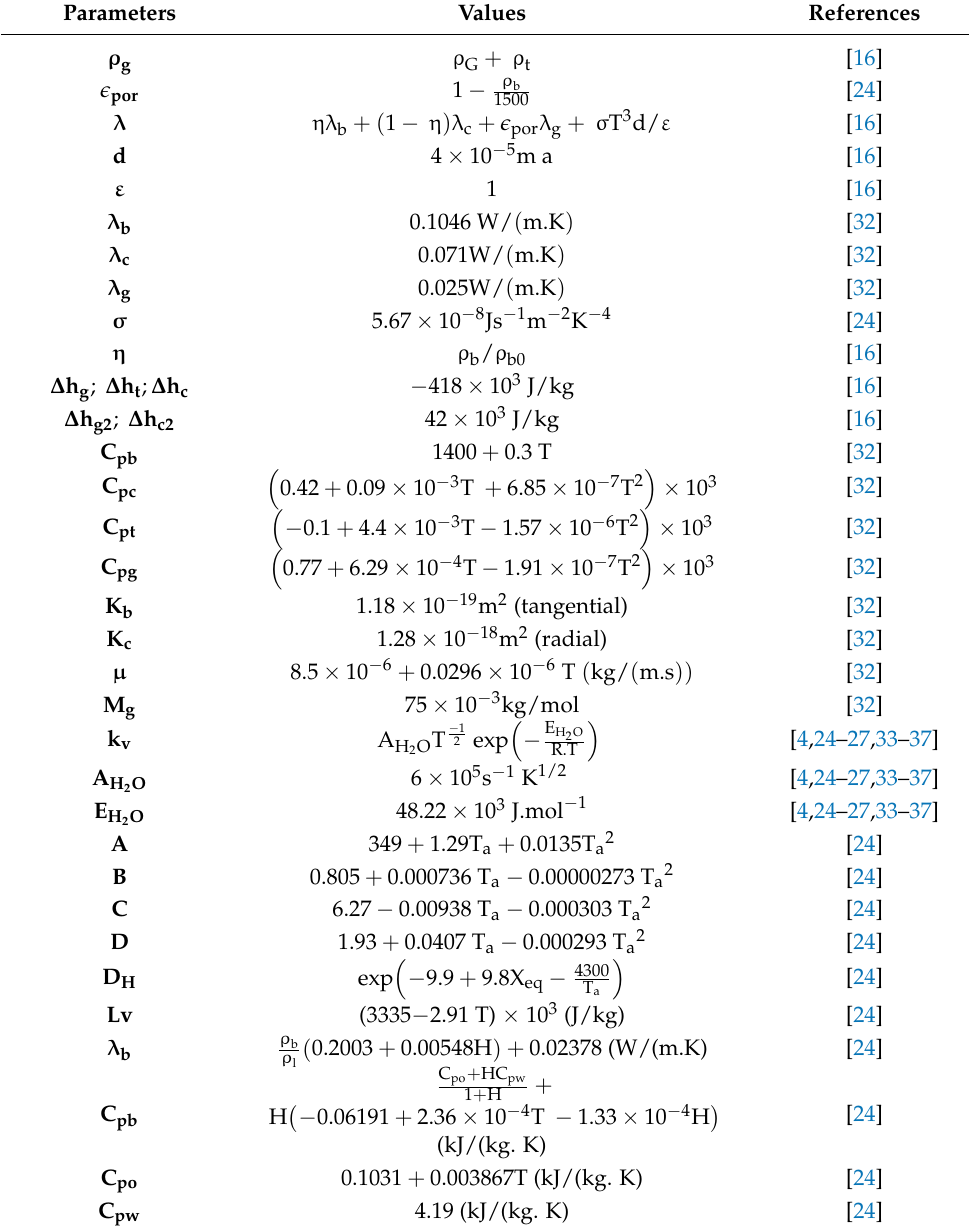
Table 2. Material properties and kinetic parameters for model equations.